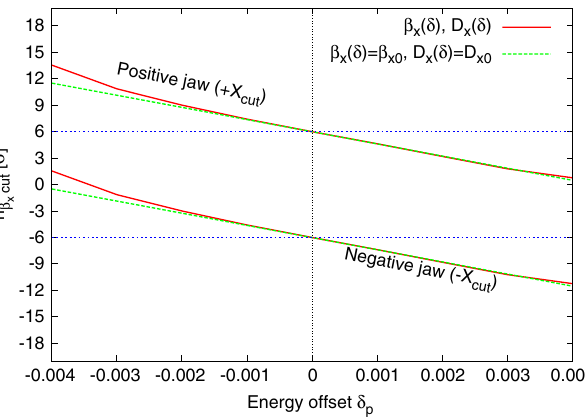
FIG. 5. (Color) Off-momentum phase space cut at the primary collimator TCP.C6L7.B1 (with D x ¼ 0 : 38 m ).